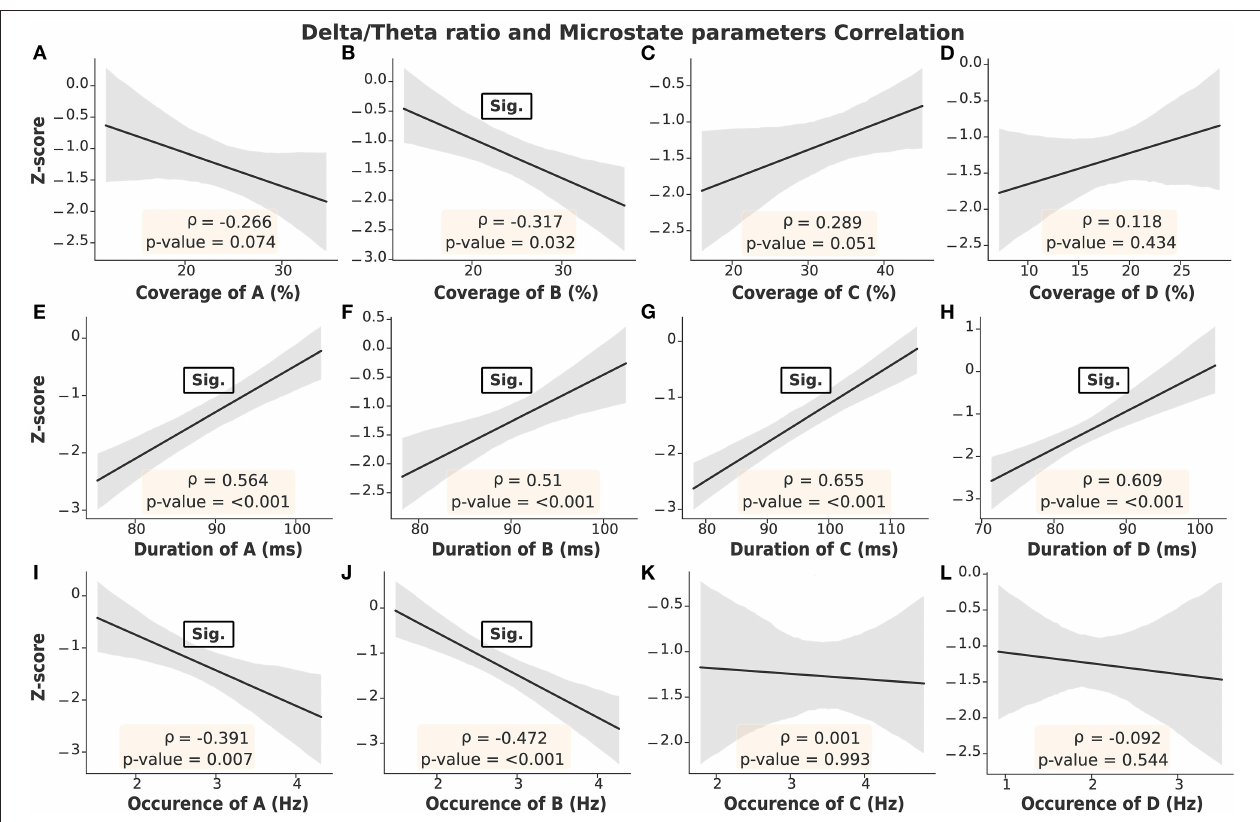
FIGURE 5 | Strong correlations were obtained between the delta/theta ratio and the duration of each microstate, as seen in (E–H) . Fair correlations are shown in (B,I,J) . On the other hand, insignificant correlations were found in (A,C,D) . Gray: 95%